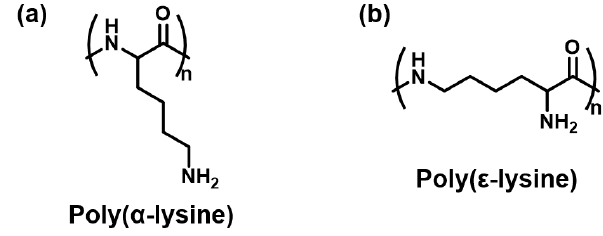
Figure 6. Chemical structures of ( a ) α -PL and ( b ) ε -PL.